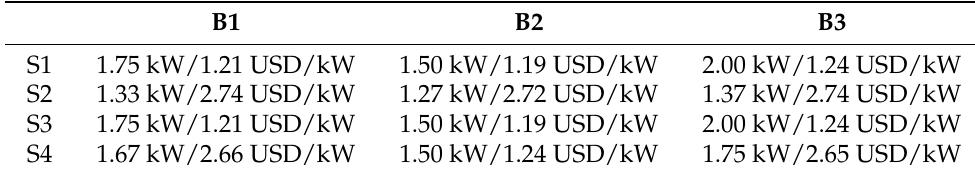
Table 2. Final traded quantities and prices of